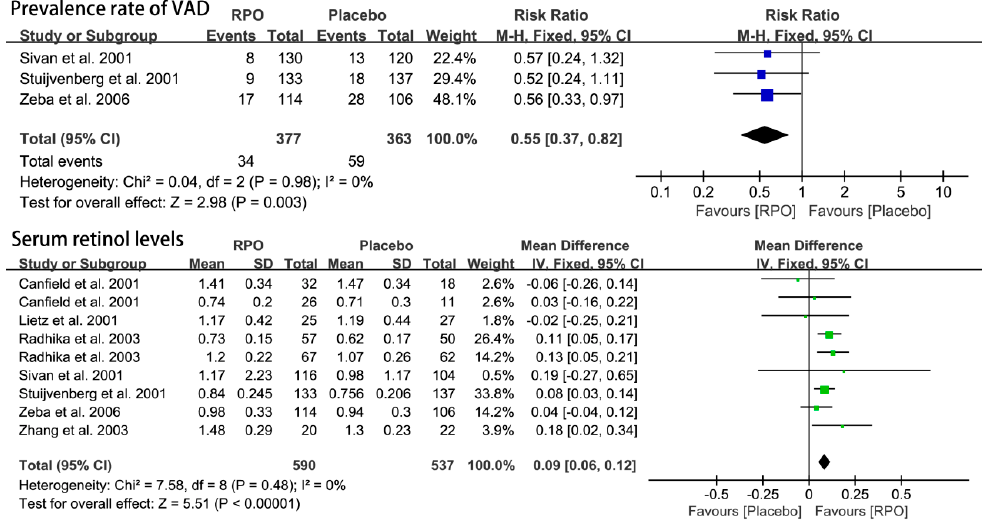
Figure 2. Forest plot of the effect of red palm oil (RPO) supplementation on the prevalence rate of vitamin A deficiency (VAD) and serum retinol levels ( μ mol/L) (RPO group vs. placebo group). CI: confidence interval.